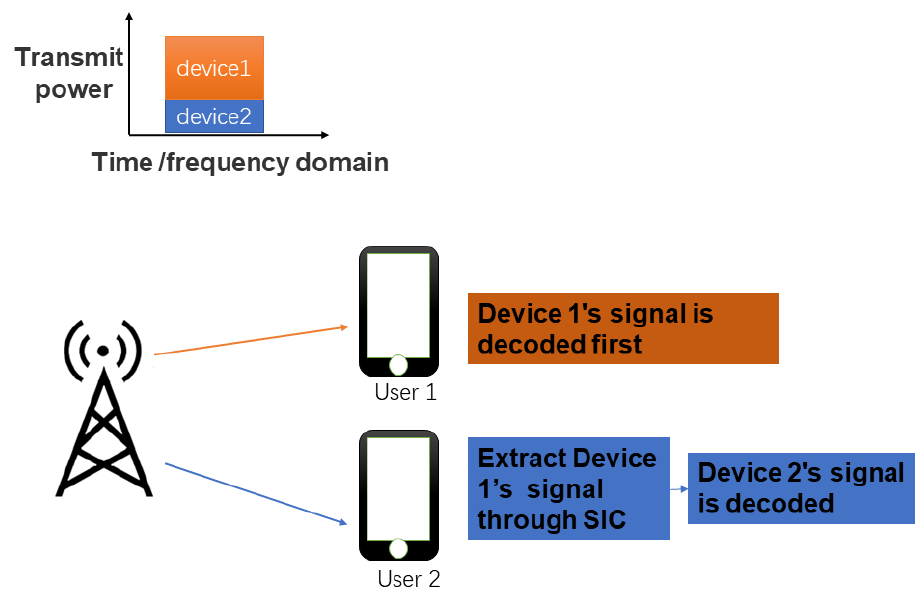
Figure 1. Downlink NOMA network with two